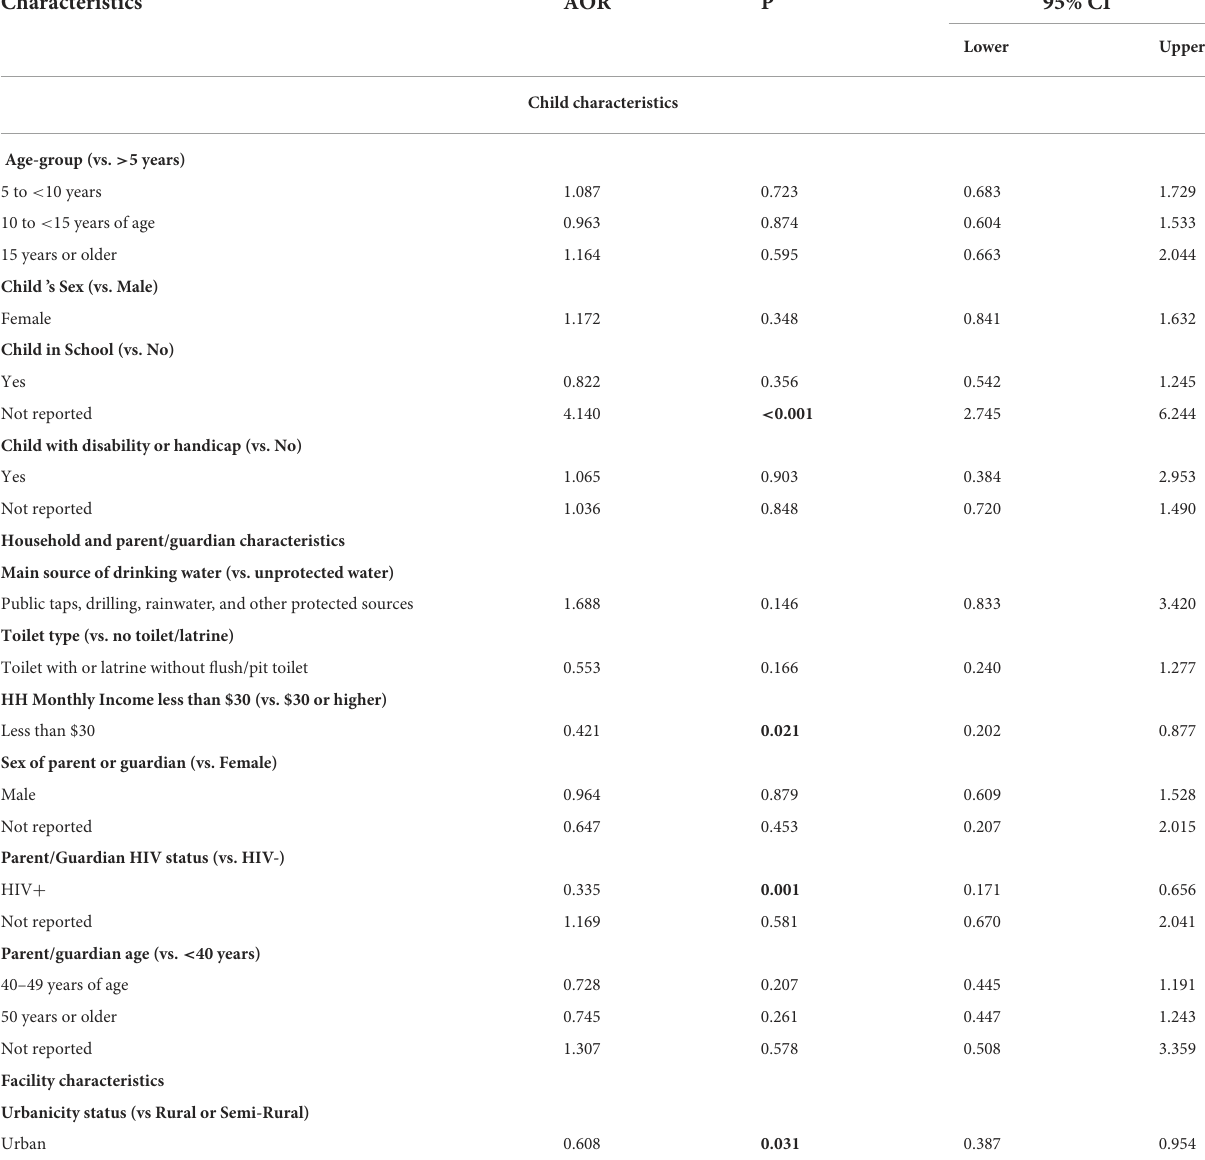
TABLE 3 Firth’s Logistic regression of HIV Status in OVC, Jan. 2017 to Apr. 2020. Characteristics AOR P 95% CI Lower Upper Child